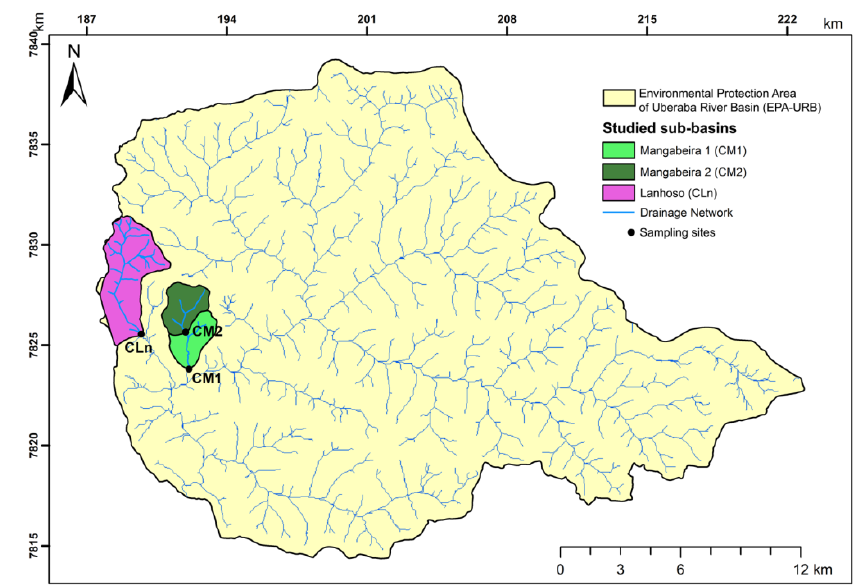
Figure 2. Experimental sites (sub-basins Mangabeira 1, Mangabeira 2 and Lanhoso).